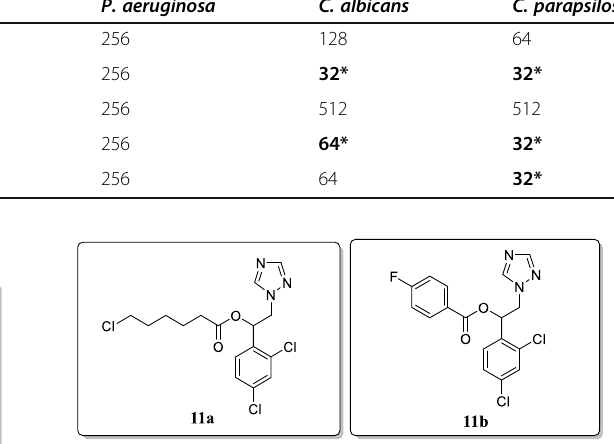
Table 2 Minimum inhibition of concentration compound ( μ g/mL)